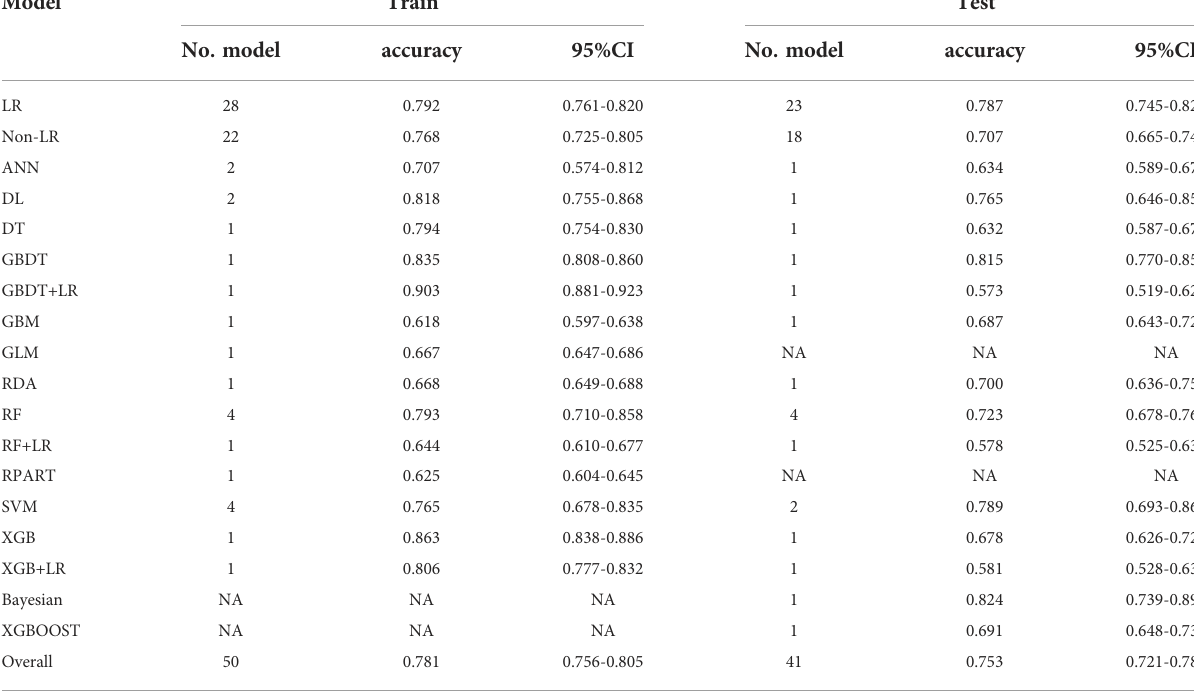
No. model indicates the number of prediction models. ANN, arti fi cial neural network; DL, deep learning; DT, decision tree; GBM, gradient boosting machine; GLM, generalized linear model; LR, logistic regression; NA, not available; No., number; Non-LR, non logistic regression; RDA, regularized dual averaging; RF, random forest; SVM, support vector machine;